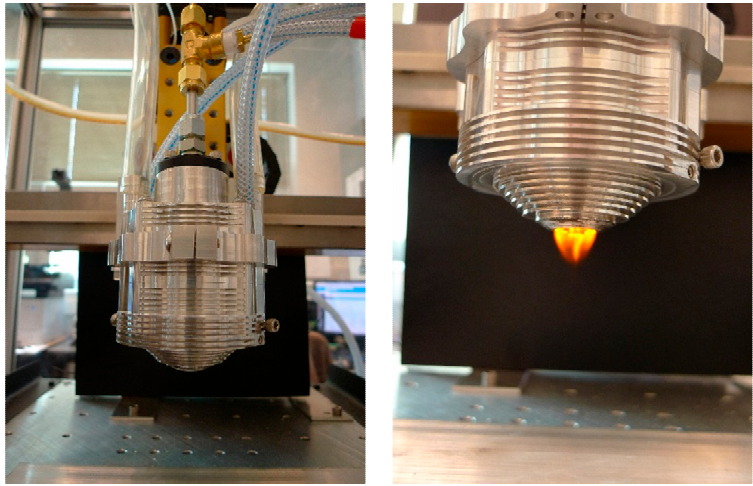
Figure 3. The nozzle system mounted on a CNC router and generated flame.